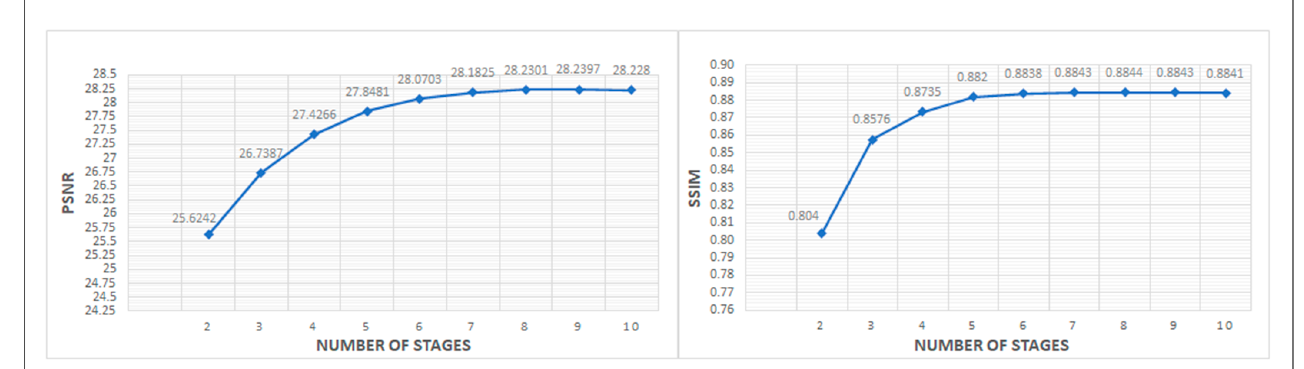
Figure 5. Effect of increasing number of progressive stages in rain streak removal on PSNR and SSIM evaluation metrics.